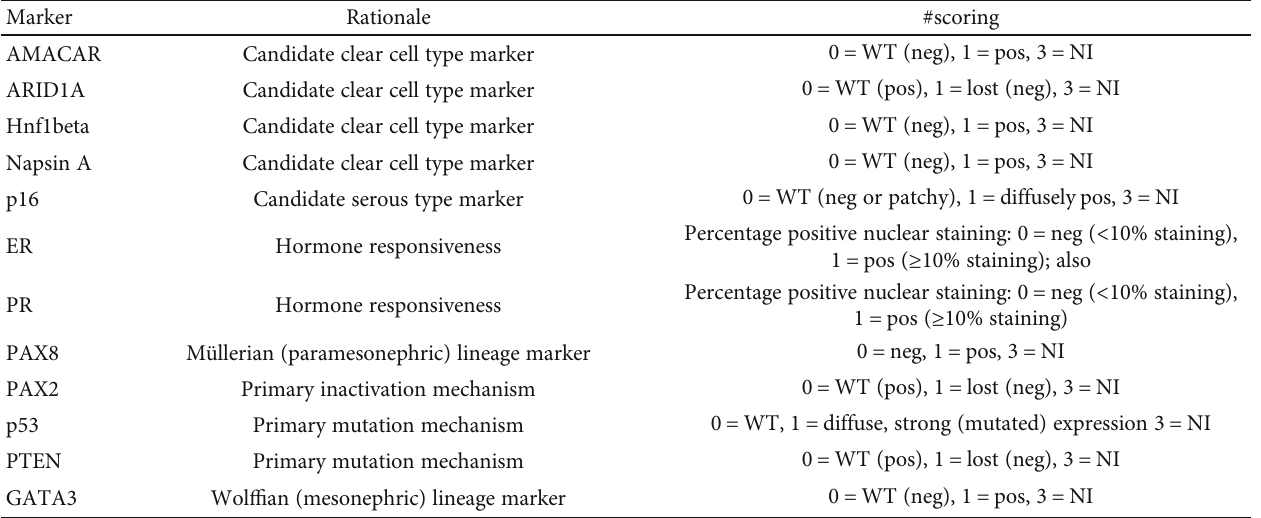
Table 1: Biomarker scoring and rationale for